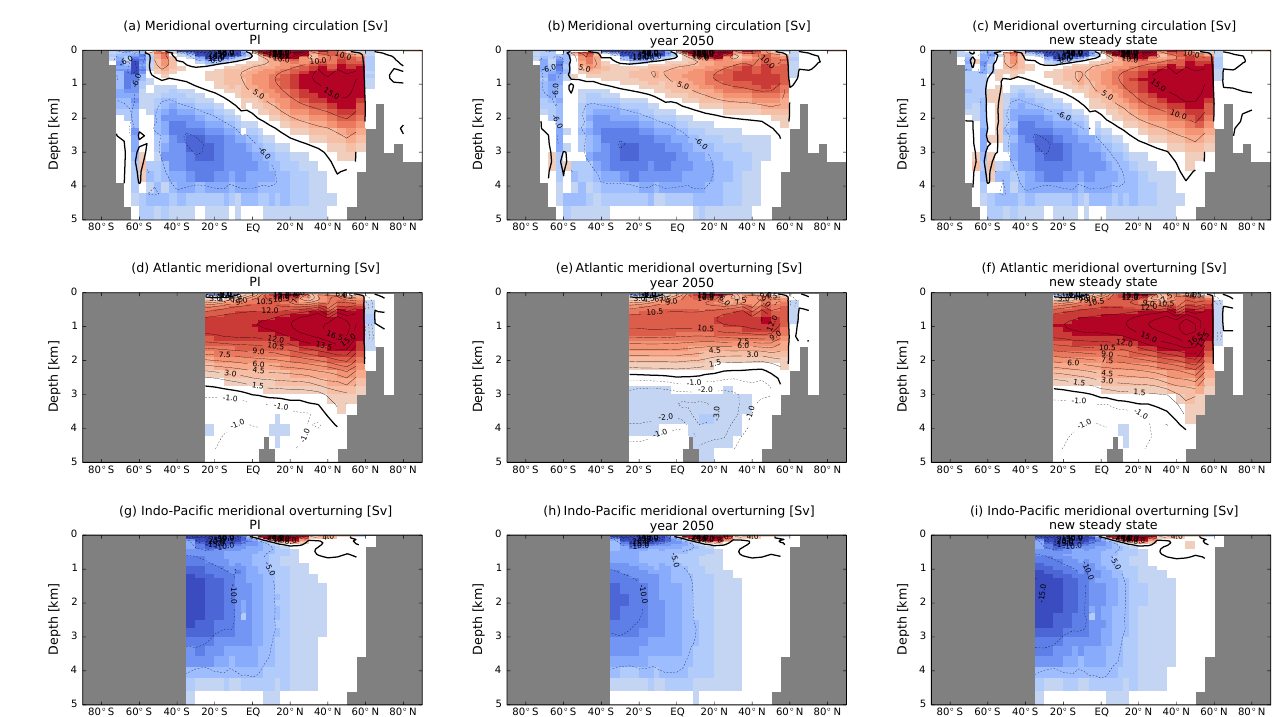
Figure A1. Meridional overturning stream function in (a–c) the world ocean, (d–f) Atlantic Ocean and (g–i) Indo-Pacific for PI, year 2050, and for new steady-state conditions for a representative ensemble member reaching the 1.5 ◦ C warming target (columns). Circulation is clockwise along positive (red) contours and anticlockwise along the negative (blue)